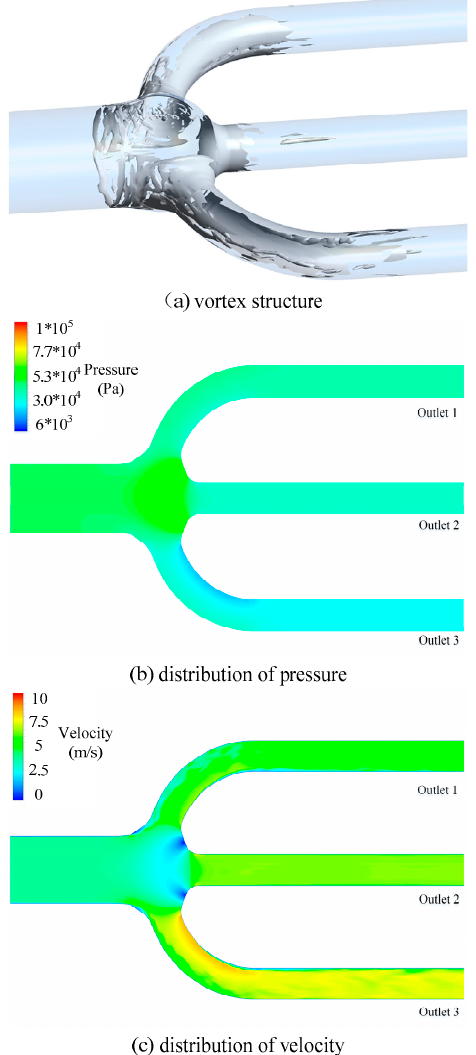
Figure 15. The flow pattern in the penstock: ( a ) the vortex structures; ( b ) distribution of pressure; ( c ) distribution of velocity (case 2).